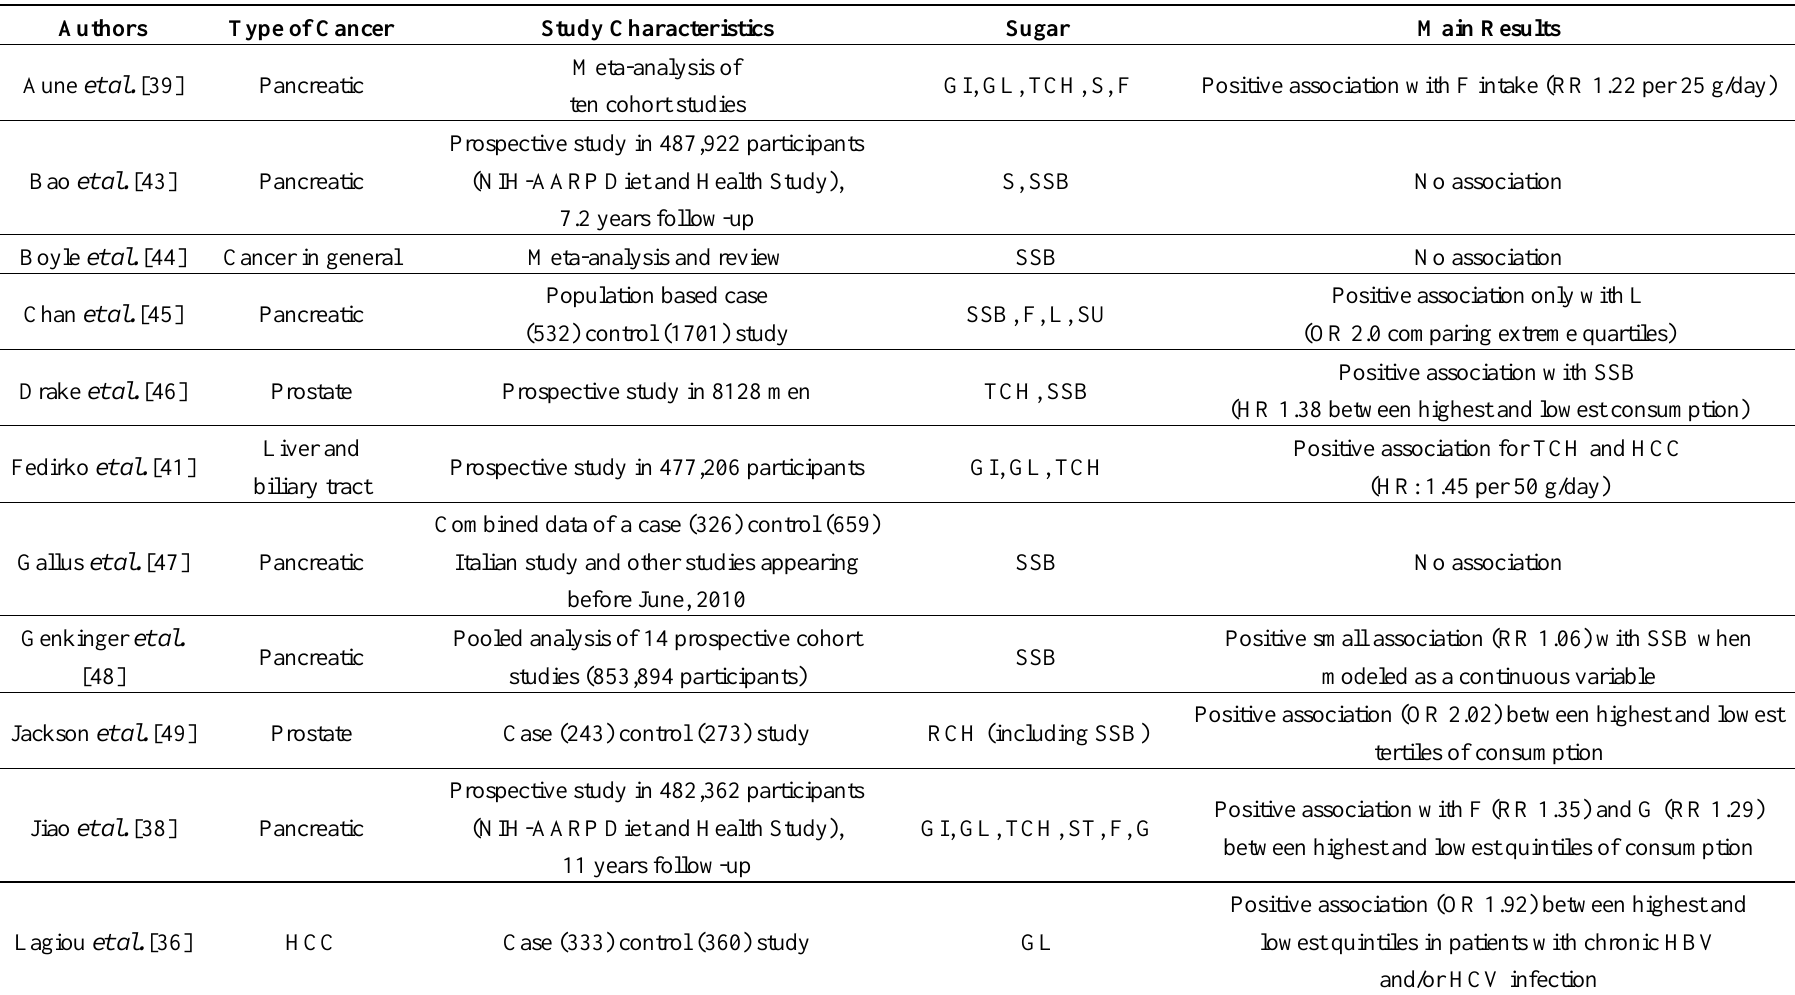
Table 1. Overview of human studies focused on cancer development and simple sugar